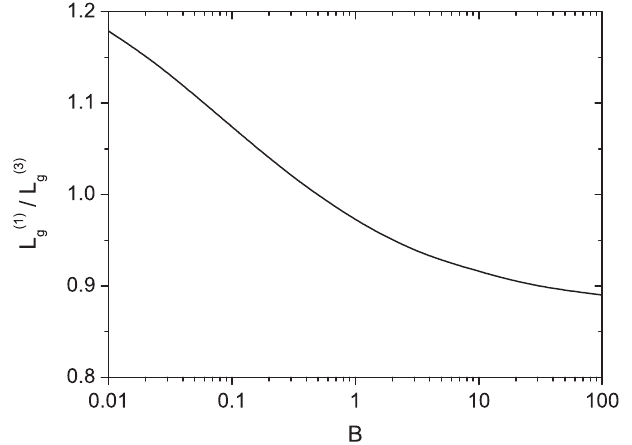
FIG. 5. Diffraction parameter of the fundamental wavelength, for which the third (solid) and the fifth (dashed) harmonics have the same gain length as the fundamental, versus the rms undu- lator parameter K . Below these curves harmonics have shorter gain lengths than the fundamental